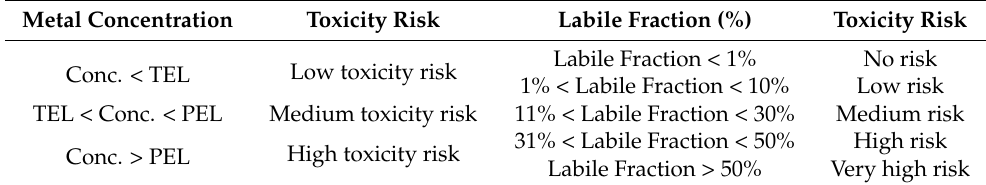
Table 1. Classification according to the Sediment Quality Guidelines (SQGs) proposed by MacDonald et al. 1994 (left) and Risk Assessment Code (RAC) classification